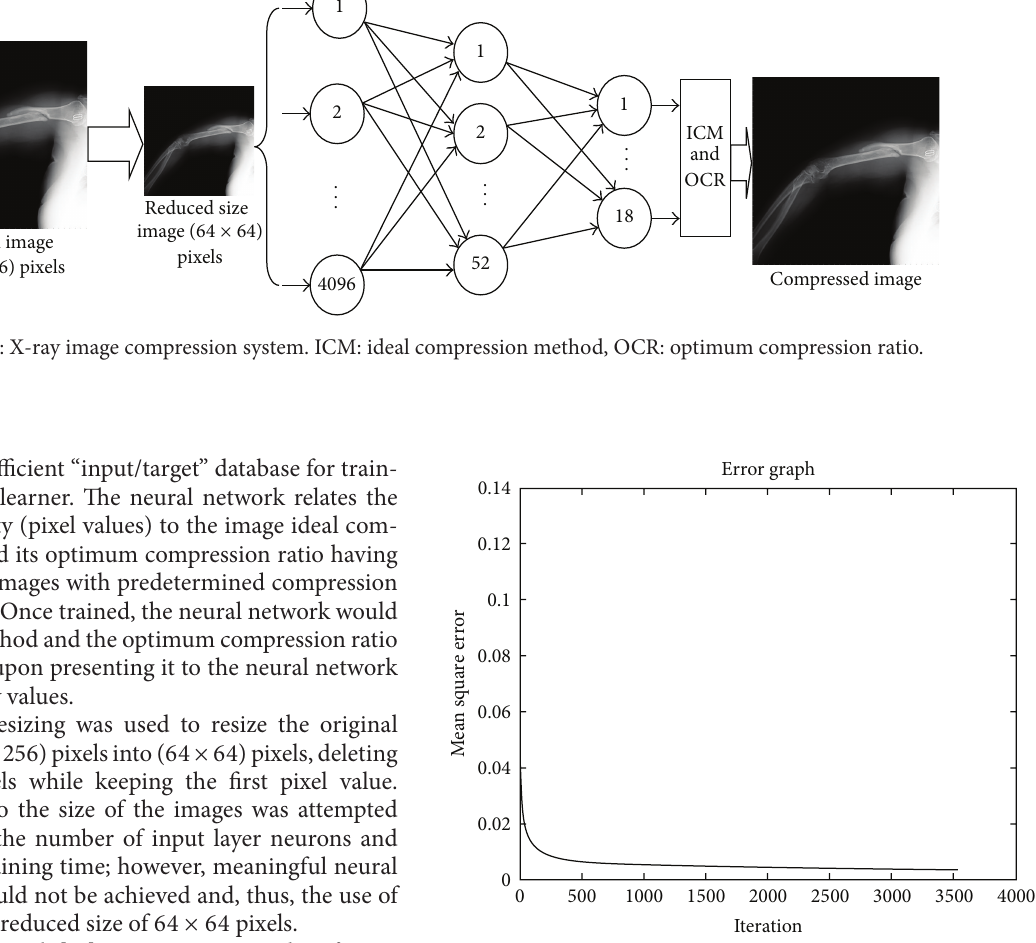
Figure 5: Neural network’s learning